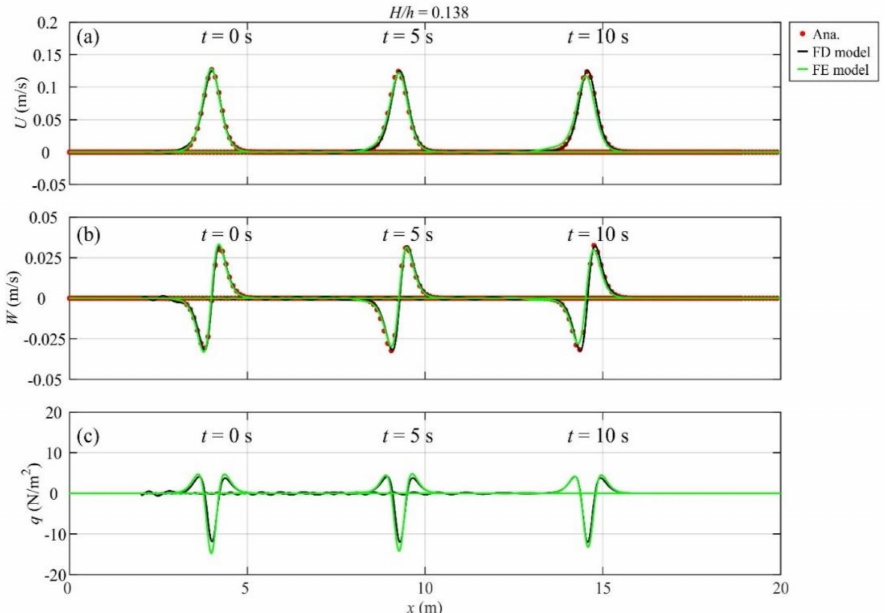
Figure 3. Comparison of approximations with computed results of a propagating solitary wave in a flat channel at t = 5 and 10 s: ( a ) horizontal velocity, ( b ) vertical velocity, and ( c ) dynamic pressure, respectively (circles denote analytical solution; black lines denote FD model results; green lines denote FE model results).